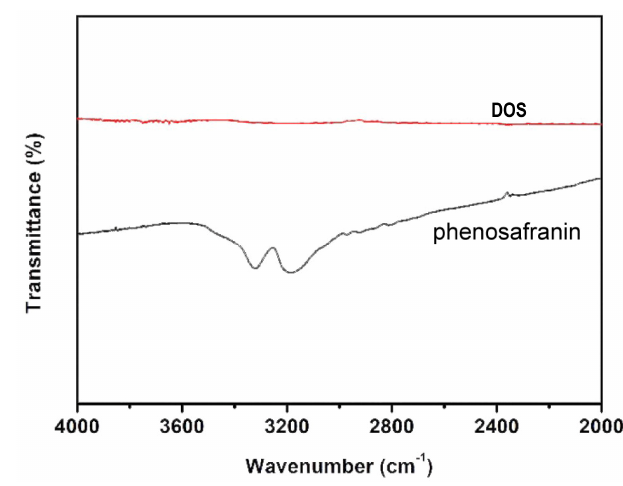
Figure 3. Fourier-transform infrared spectroscopy (FT-IR) spectra of phenosafranin and DOS.